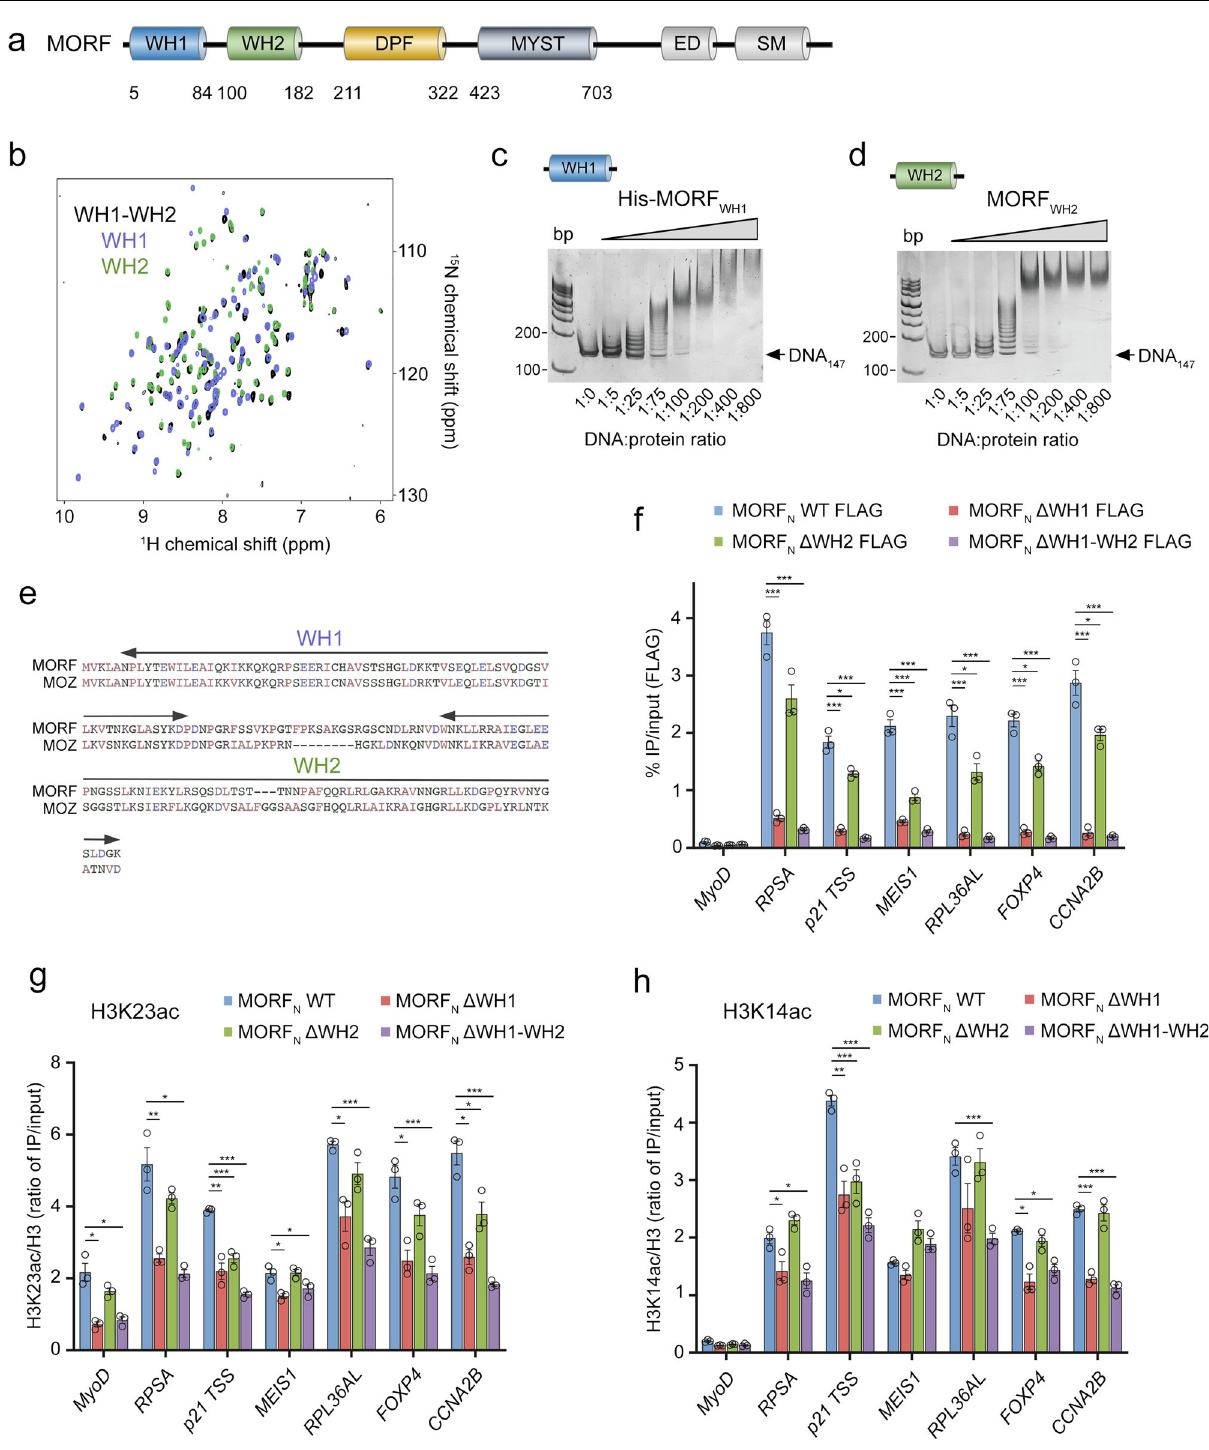
Fig. 1 | MORF and MOZ contain two DNA-binding WH domains. a Domain architecture of MORF with the MORF WH1 , MORF WH2 and MORF DPF colored blue, green and wheat, respectively. b Overlay of 1 H, 15 N HSQC spectra of 15 N-labeled MORF WH1-WH2 (black), MORF WH1 (blue) and MORF WH2 (green). c , d EMSA of 147bp 601 DNA in the presence of increasing amounts of His-MORF WH1 and MORF WH2 . DNA:protein ratio is shown below the gel images. e Alignment of amino acid sequencesoftheN-terminalregions(1 – 200)ofMORFandMOZ.BoundariesofWH1 and WH2 are indicated by arrows. f – h Anti-FLAG ChIP-qPCR analysis in K562 cells